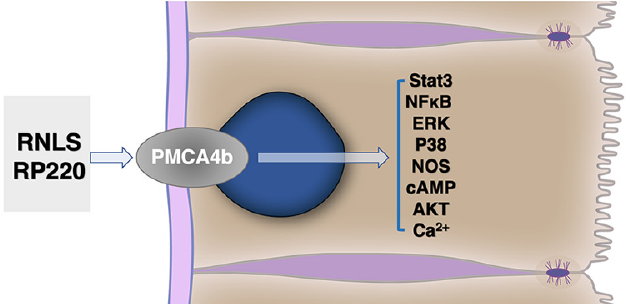
Figure 3. Renalase signaling through the plasma-membrane calcium ATPase (PMCA4b) is linked to the stimulation of multiple downstream signals. Some of the same signaling pathways activated by RNLS and RP-220 have also been linked to PMCA4b signaling. These include the Ras/Raf/MEK/ERK, p38, NOS, NF- κ B, cAMP, and AKT pathways [12,53 – 55]. One study described an interesting potential feed- back loop, finding that p38 (which is upregulated with RNLS treatment) induces degra- dation and downregulation of PMCA4b [55]. When treated with a p38 inhibitor, PMCA4b